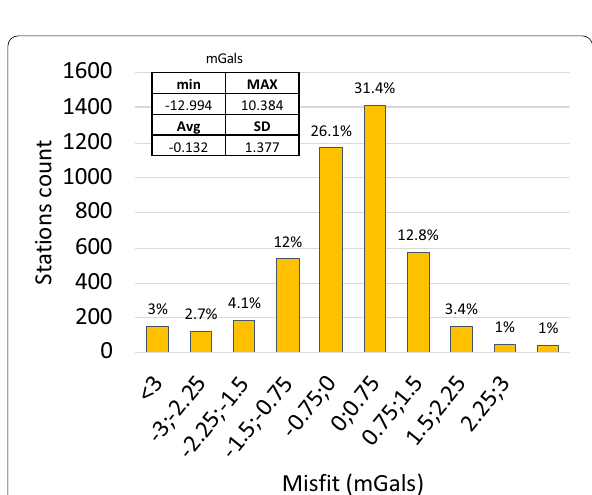
Fig. 5 Distribution of the uncertainty in the gravity dataset due to the combined effects of the elevation data and the applied gridding